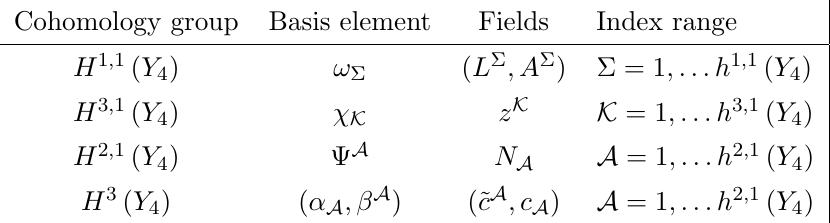
Table 3 . Relevant cohomology groups in the reduction on Y 4 . The dimensions are denoted by h p;q ( Y 4 ) = dim H p;q ( Y 4 ). While (cid:9) A and (cid:31) K are complex basis elements, the forms ! (cid:6) and ( (cid:11) A ; (cid:12) A ) constitute real basis